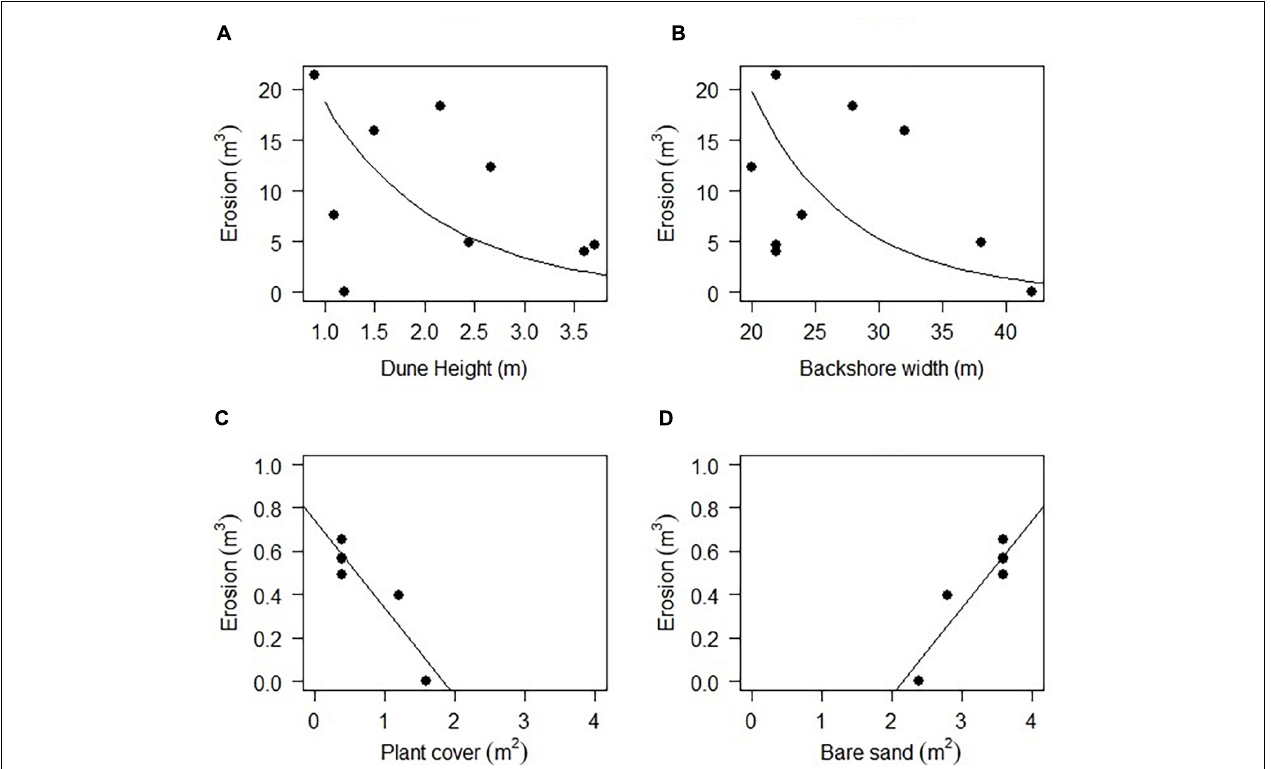
FIGURE 11 | Erosion as a function of (A) dune height, (B) backshore width, (C) plant cover and (D) bare sand.